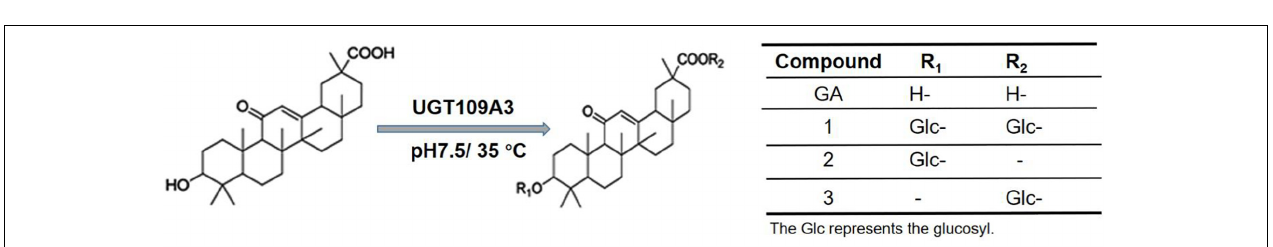
FIGURE 2 | Enzymatic glycosylation of GA with UGT109A3. (A) HPLC analysis of glycosylation products; the elution was monitored at 254 nm. (B) LC–ESI-MS analysis of GA-glycoside products synthesized by UGT109A3. The mass data showed an (M + H) + ion peak at m/z: 795.441 in the ESI-MS spectrum, corresponding to GA diglucoside product.